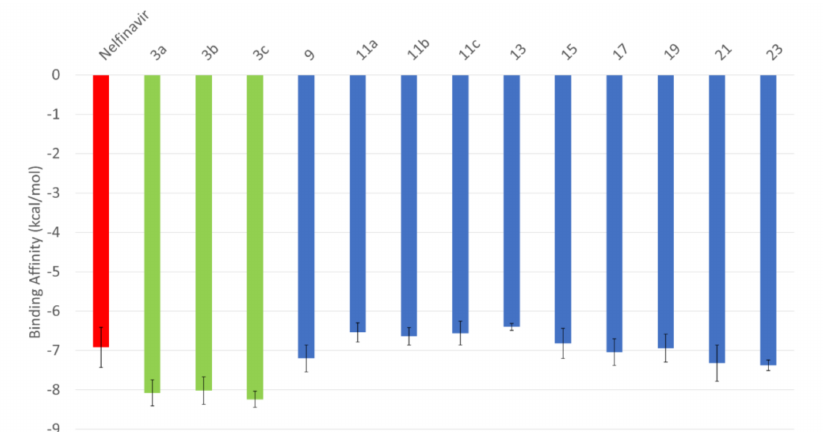
Figure 2. Average binding energies (in kcal / mol) of the compounds of Nelfinavir (red) 3a , 3b , and 3c (green), and 9 , 11a , 11b , 11c , 13 , 15 , 17 , 19 , 21 , and 23 (blue) docked into the active site residues of SARS-CoV-2 PL pro . Error bars represent the standard